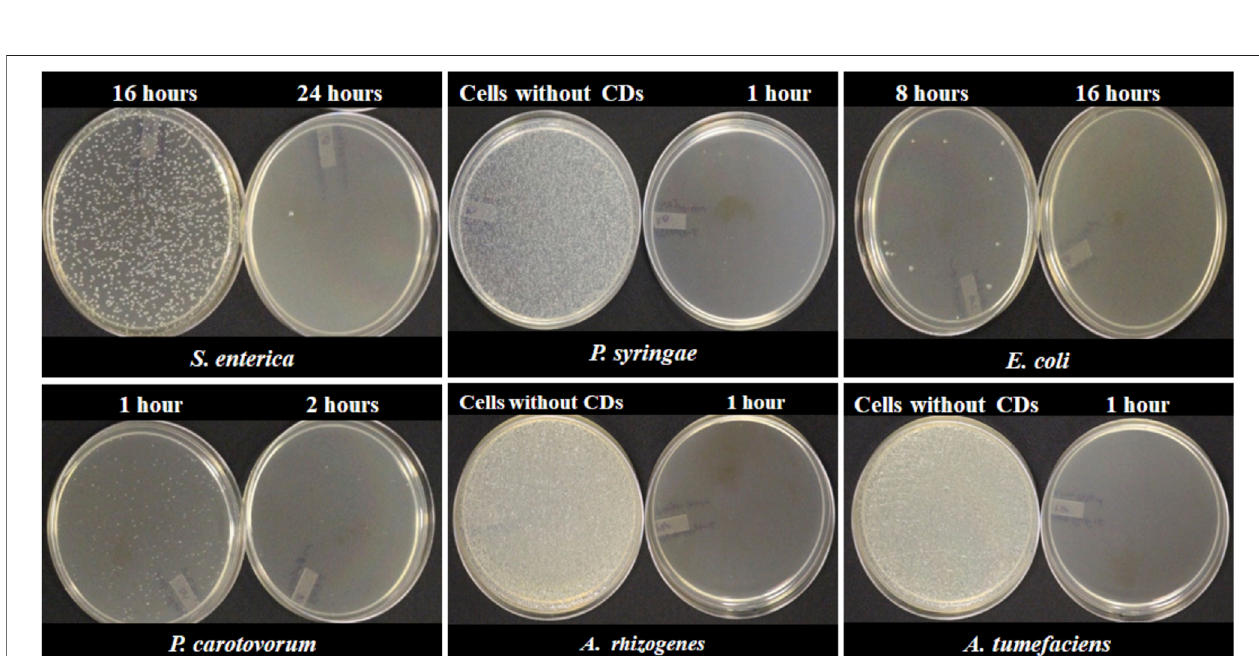
FIGURE 8 | Minimum time required for complete inhibition of different bacterial cells using NH2-FCDs.